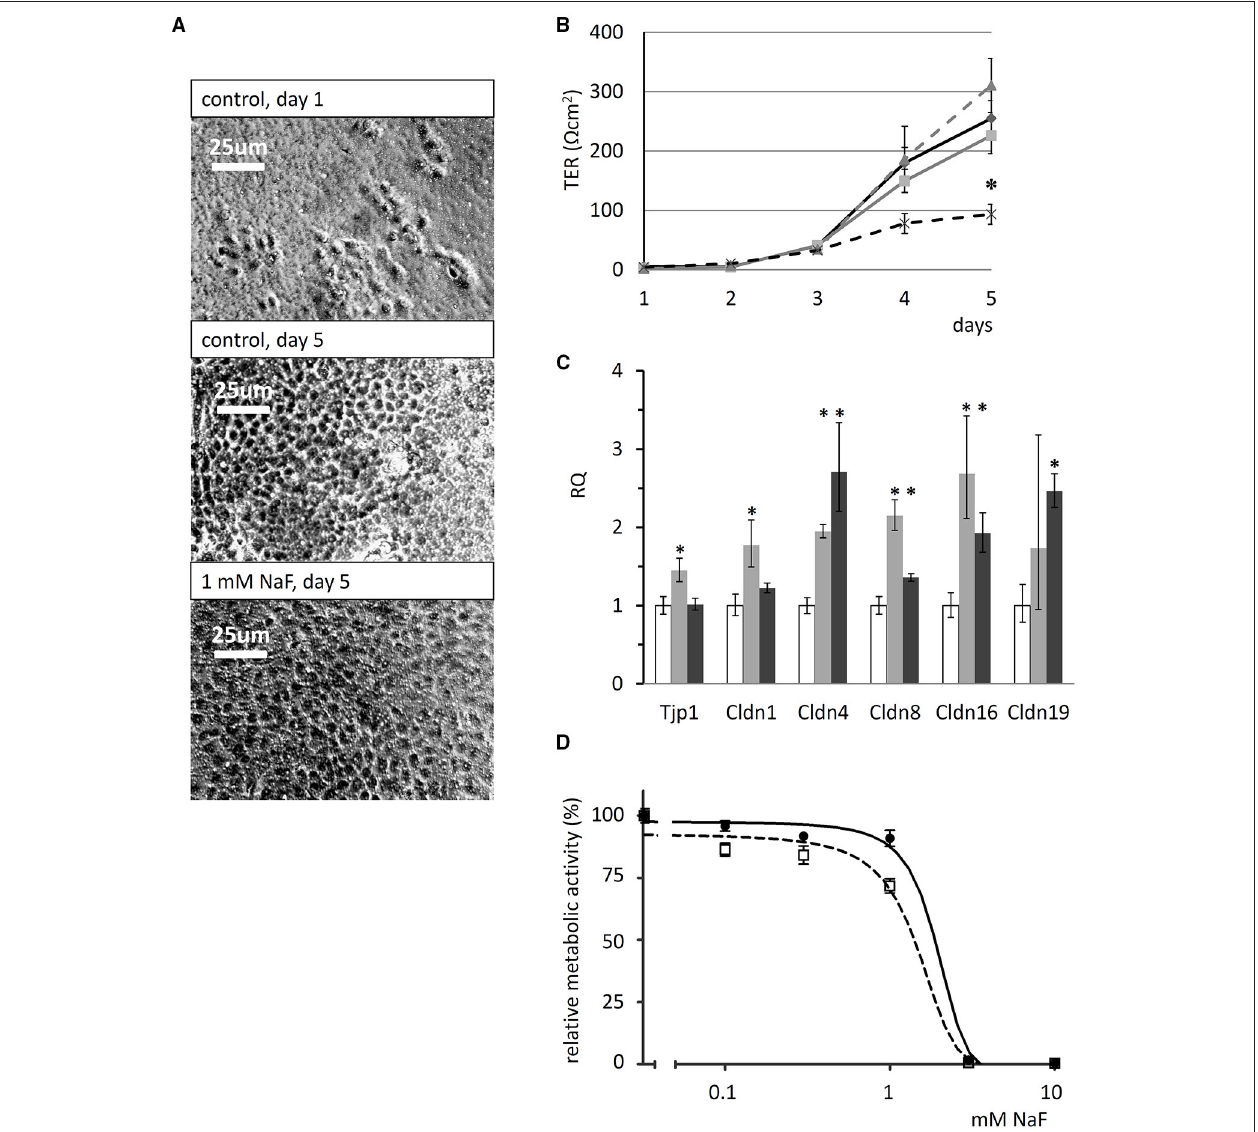
FIGURE 6 | Effects of fluoride on transepithelial resistance, tight-junction protein expression and cell viability of HAT-7 cells . (A) Phase-contrast images of HAT-7 cells grown on Transwell membranes in control medium at day1 and 5 (control), or in the same medium supplemented with 1mM NaF. (B) Transepithelial resistance (TER) of the cells cultured on Transwell membranes for 5 days in the absence (solid black) and presence of 0.3mM (solid gray), 0.6mM (broken gray), or 1mM NaF (broken black line). A significant difference in TER was observed after 5 days when cells cultured with 1mM NaF were compared to controls: * p < 0.05. (C) Quantitative RT-PCR data showing expression of tight-junction genes Tjp1, Cldn1, Cldn4, Cldn8, Cldn16, and Cldn19 genes, normalized to mitochondrial Rplpo gene expression in HAT-7 cells treated as described above ( n = 3 for each gene). Changes in gene expression following treatment with 0.6mM (gray) and 1mM (black) NaF are compared to controls (white): * p < 0.05; error bars show 95% confidence intervals. (D) Concentration dependence of the effect of NaF on the metabolic activity of HAT-7 cells treated for 48h (black circles, continuous line) and 96h (empty rectangles, broken line) ( n = 6 for each NaF